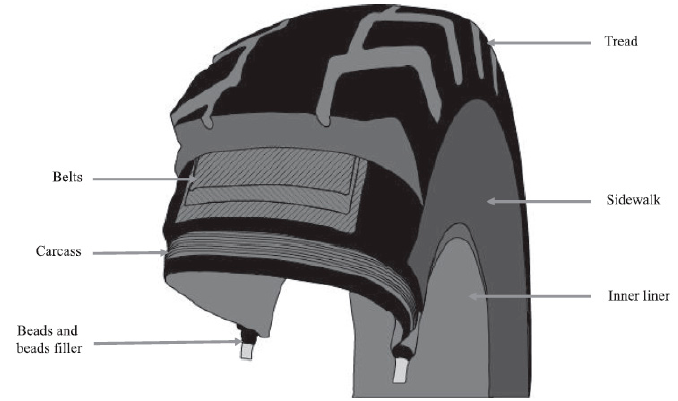
Figure 1. Typical tire structure (reproduced with permission from [28]).